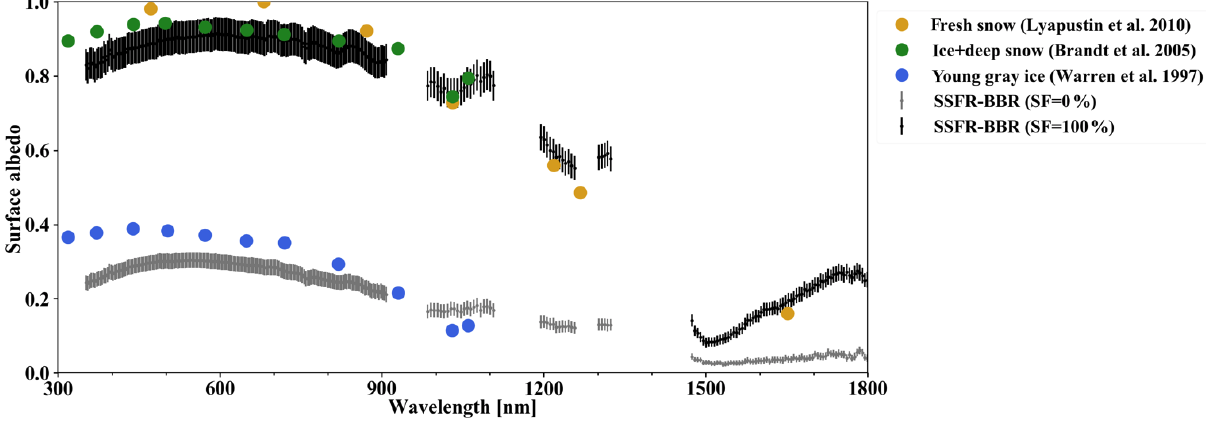
Figure 5. Spectral surface albedo derived from SSFR–BBR measurements for SF = 100% (black) and SF = 0 (gray), along with their uncertainties. In addition, different albedos from the literature are shown for